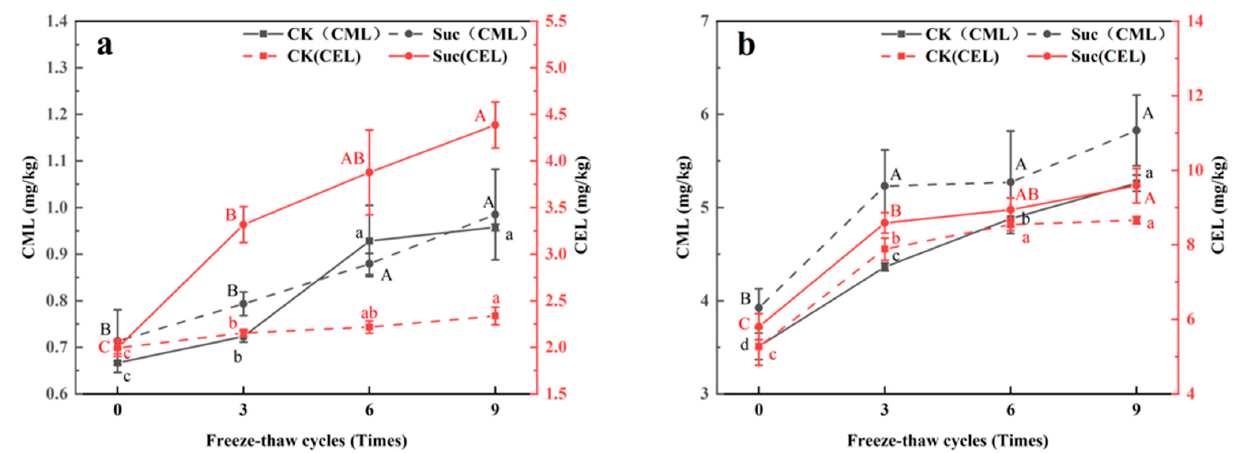
Figure 2. Changes of N ε -carboxymethyllysine (CML) and N ε -carboxyethyllysine (CEL) contents in ground pork during freeze ‒ thaw cycles and subsequent heating. ( a ). raw; ( b ). 100 °C, 30 min cooked). a,b,c,d Different letters indicate significant difference ( α = 0.05) of CML and CEL contents in CK groups during freeze ‒ thaw cycles. A,B,C, Different letters indicate significant difference ( α = 0.05) of CML and CEL contents in Suc groups during freeze ‒ thaw cycles.